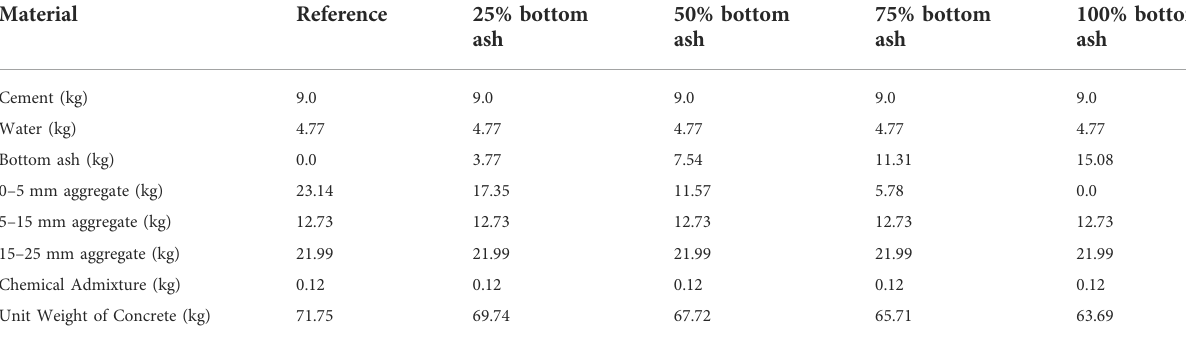
TABLE 2 Components in the CSs and weight per unit of components (Karalar, 2020; Karalar et al., 2020).